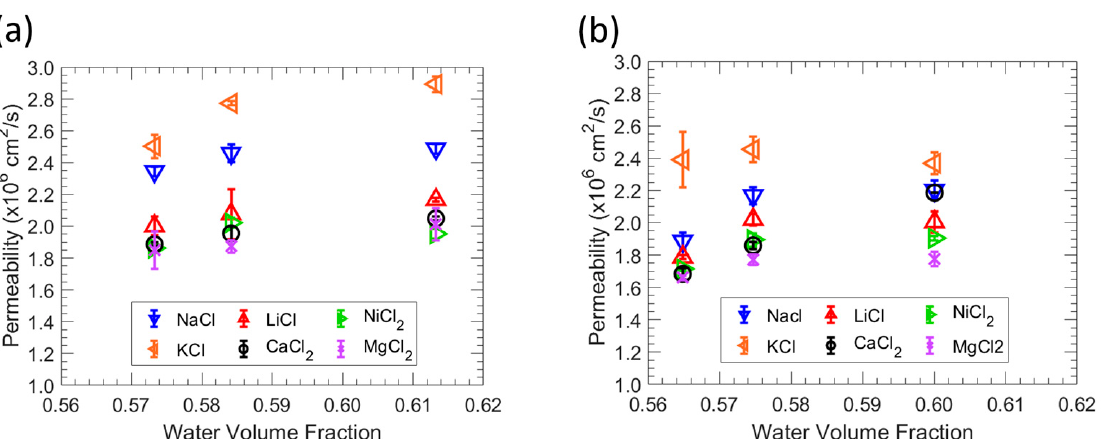
Figure 5. ( a ) Correlation between permeability and water volume fraction in MBAA 10 zwitterionic polymer. ( b ) Correlation between permeability and water volume fraction in MBAA 20 zwitterionic polymers. The average of three experiments is shown by each data point, and the error bars repre- sent the standard deviation.